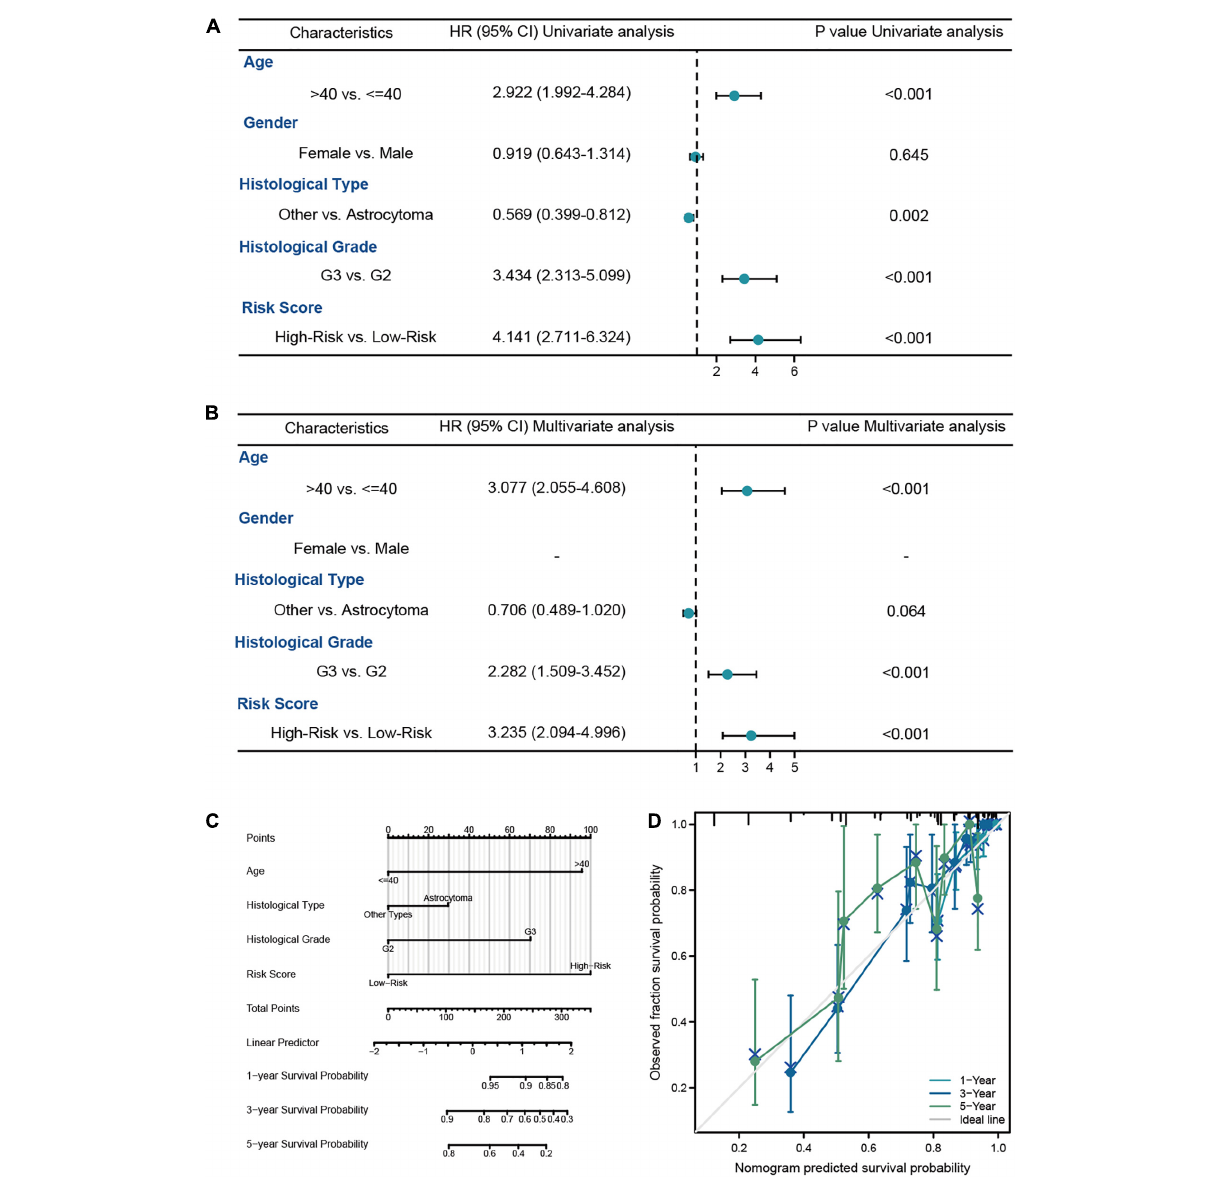
FIGURE4 The survival analysis of risk model in LGG patients from TCGA-LGG dataset. (A,B) The univariate and multivariate Cox regression analysis of OS in LGG patients from the training cohort. (C) The nomogram for the prediction of 1-, 3-, and 5-year OS in LGG patients. (D) Calibration plot of the nomogram in LGG